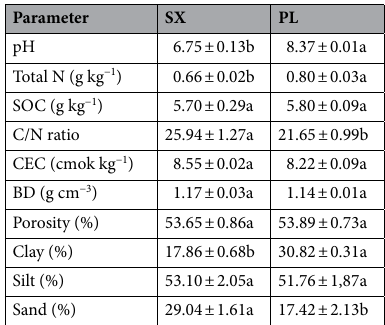
Table 1. Some basic physical and chemical properties of tested soils. Data are mean ± standard error ( n = 3); Different letters within the same row indicate significant differences among treatments at p < 0.05